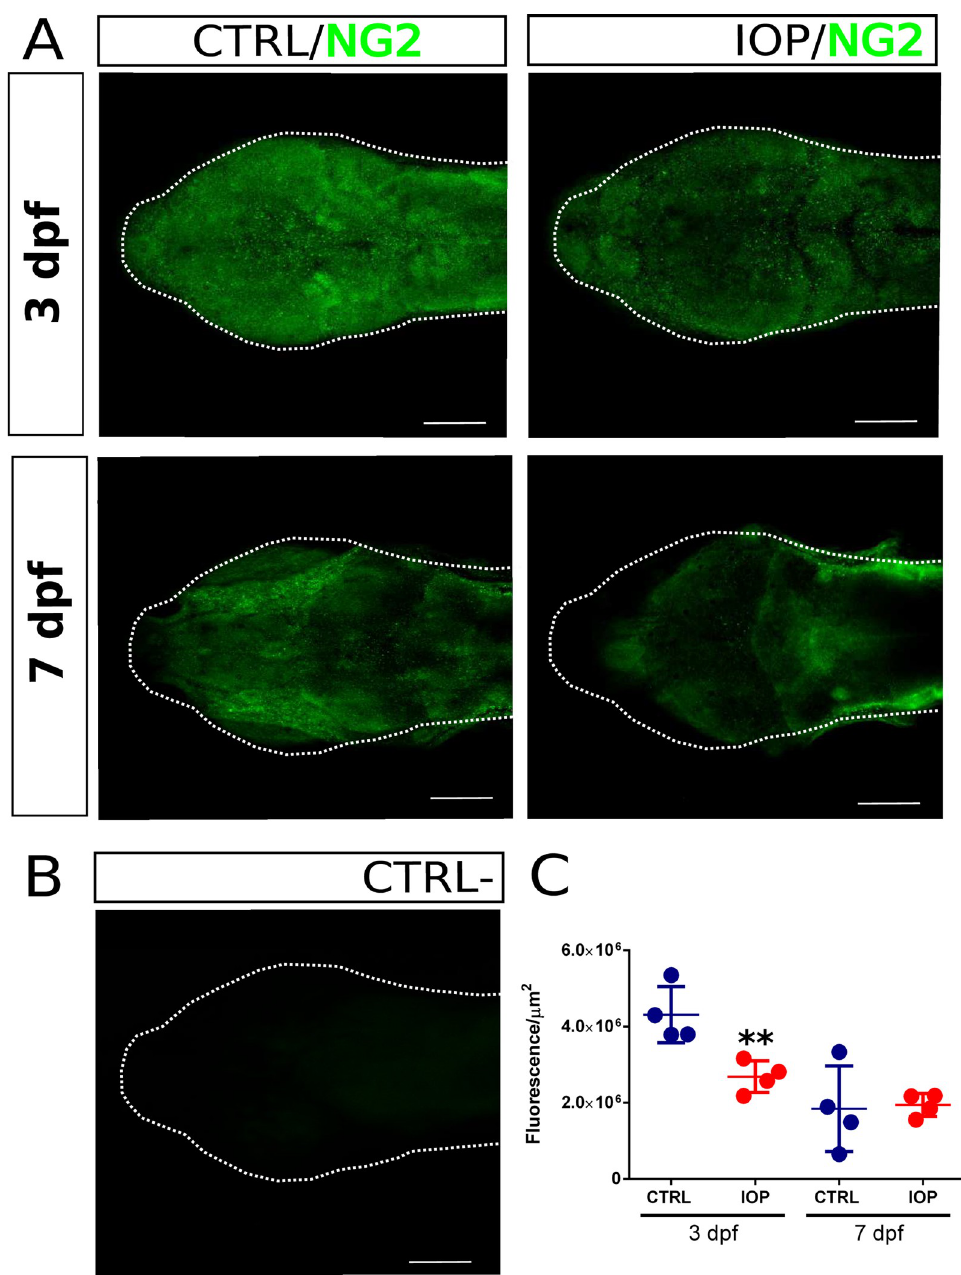
Fig 6. OPC immunostaining. Dorsal view of the head of zebrafish larva at 3 and 7 dpf. ( A ) Pictures show whole mount NG2 immunoreactivity in control (upper panel) and IOP-treated larvae (lower panel). The latter show significantly decreased immunoreactivity ( B ) Negative control (without primary antibody) ( C ) Quantification of total fluorescence intensity of NG2 immunoreactivity. Individual values and the mean ± SEM are shown (n = 5 larvae/group). Statistical analysis was performed using Student’s t test. Significant differences are indicated as �� p < 0.01. Scale bar 100 μ